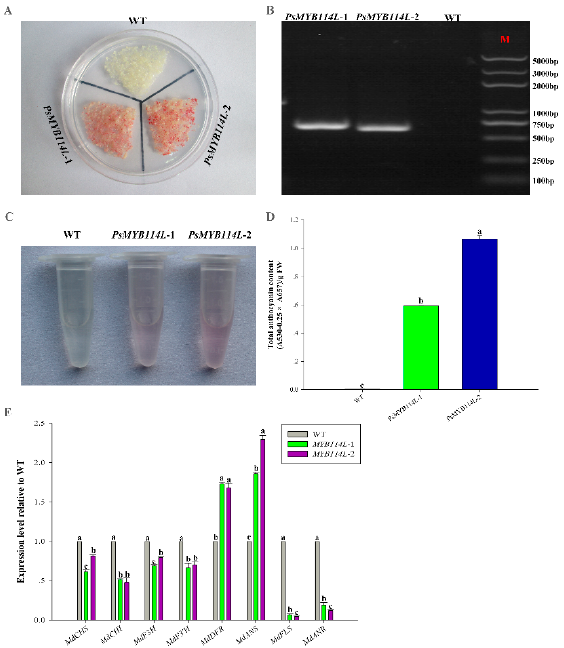
Figure 7. Overexpression analysis of the PsMYB114L gene in apple calli. ( A ) Colors observed in transgenic apple calli and the WT. ( B ) Results of positive PCR detection in transgenic apple calli. ( C ) Anthocyanin extraction solutions for transgenic apple calli and the WT. ( D ) Total anthocyanin content in transgenic apple calli and the WT. ( E ) Expression analysis of anthocyanin biosynthesis-related genes in transgenic apple calli and the WT. WT, Wild-type ‘Orin’ apple calli; PsMYB114L -1 and PsMYB114L -2, two transgenic lines of the PsMYB114L gene. Different lowercase letters indicate significant differences at p < 0.05.